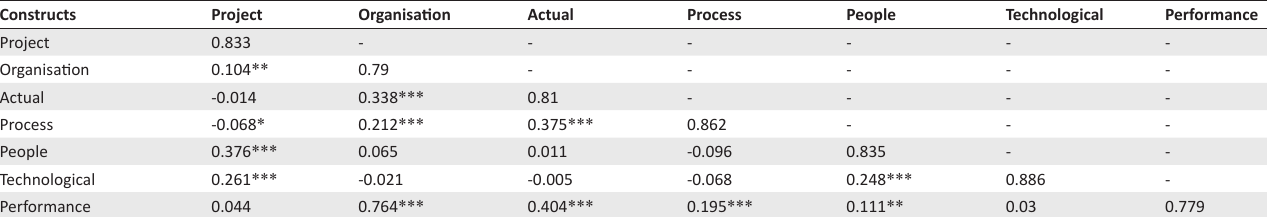
TABLE 3: The square of average variance extracted (shown as diagonal) and factor correlation coefficients.